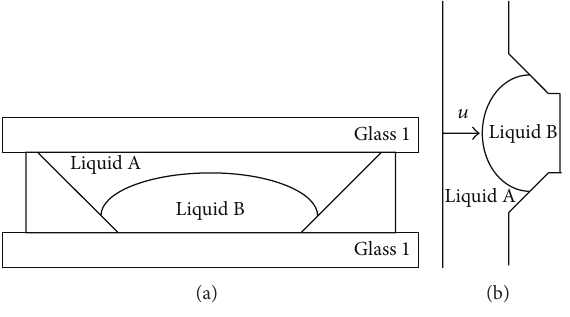
Figure 1: Liquid lens [19] (a) structure; (b) cross-section of a liquid lens.